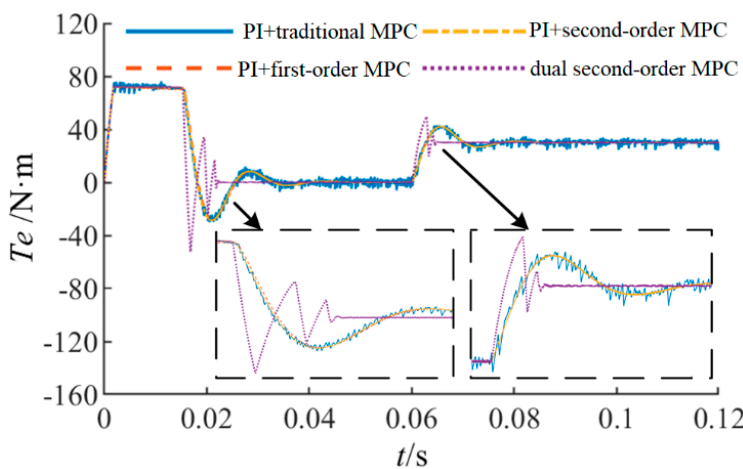
Figure 5. Speed response of four control modes.